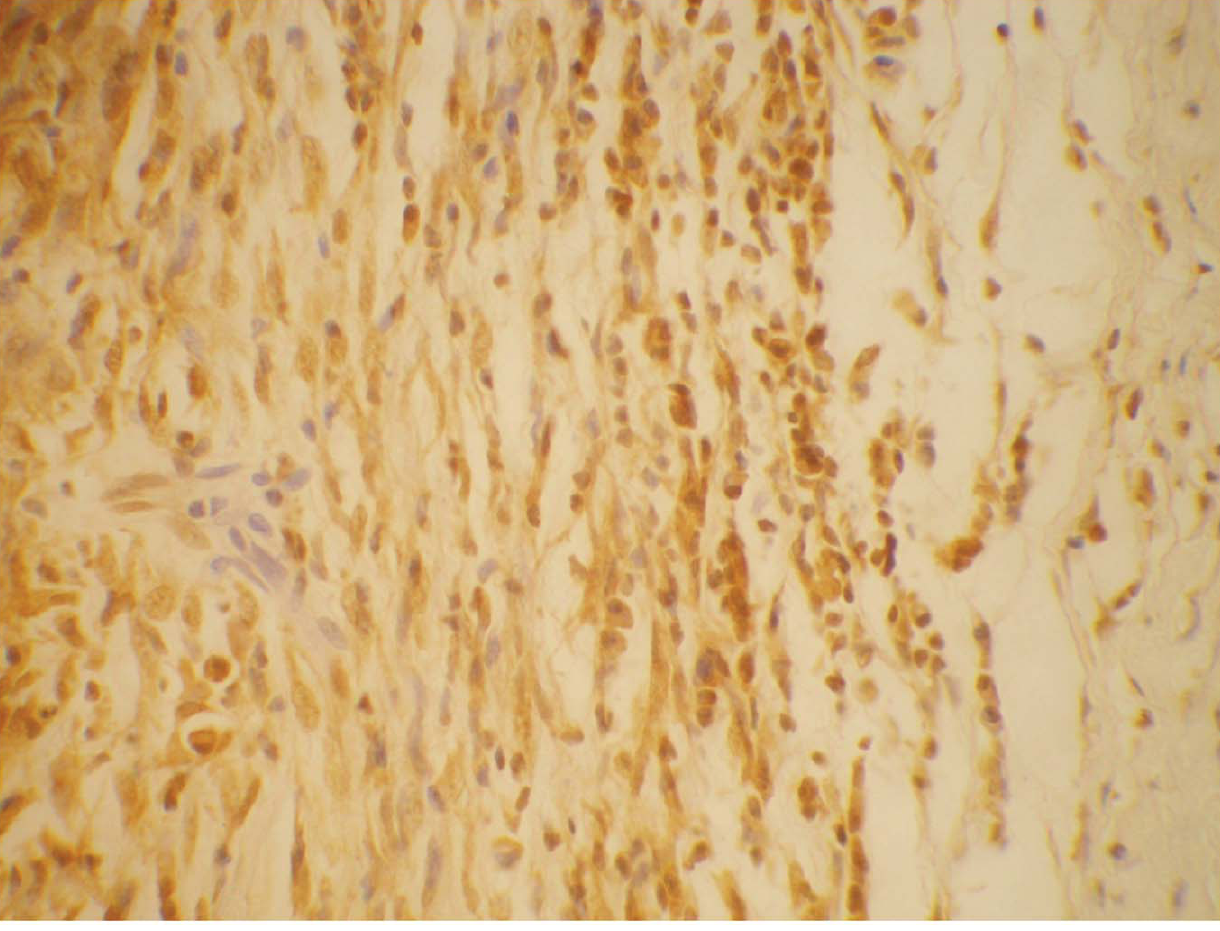
Figure 7. Nerve stained for TNF- a . Nerve showing TNF- a positive macrophages. ICH staining 6 40.